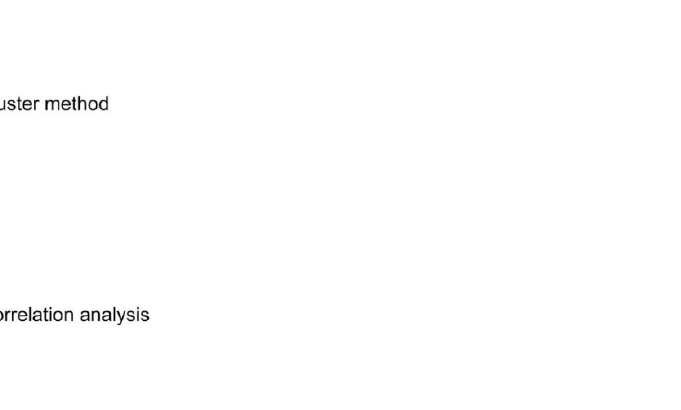
Figure 1. The C-CorA workflow showing the clustering module and a correlation analysis module. The numbers 1, 2, 3 and 4 represent the different clusters. When the k-mean is set as 4 for the cluster module, input data1 and input data 2 are first clustered into four groups. Then these groups are randomly combined into two groups for correlation analysis.